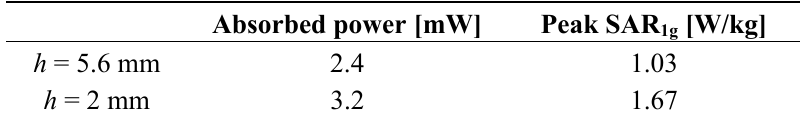
Table 2. Absorbed power and maximum SAR averaged over 1 g of skin at 60 GHz for an input power of 10 mW.